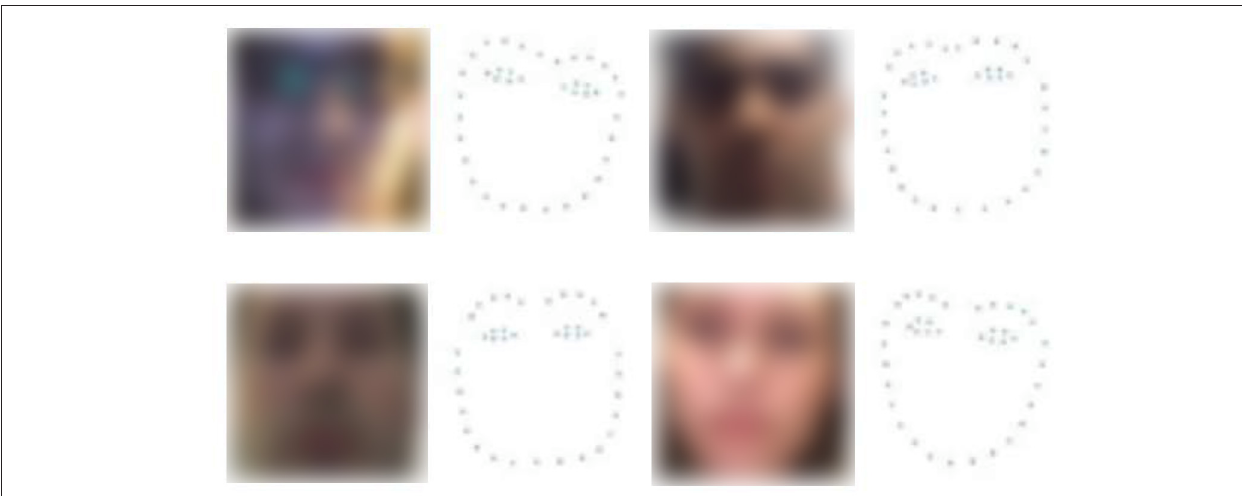
FIGURE 2 | Sample images of face and 39-point facial landmark.